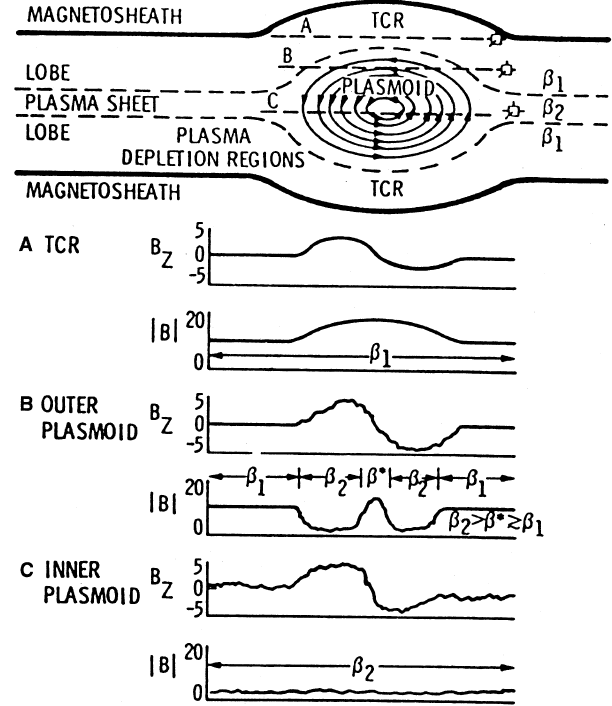
Fig. 1. Magnetic field and plasma beta variations observed along several di(cid:128)erent trajectories relative to an idealised plasmoid (from Slavin et al